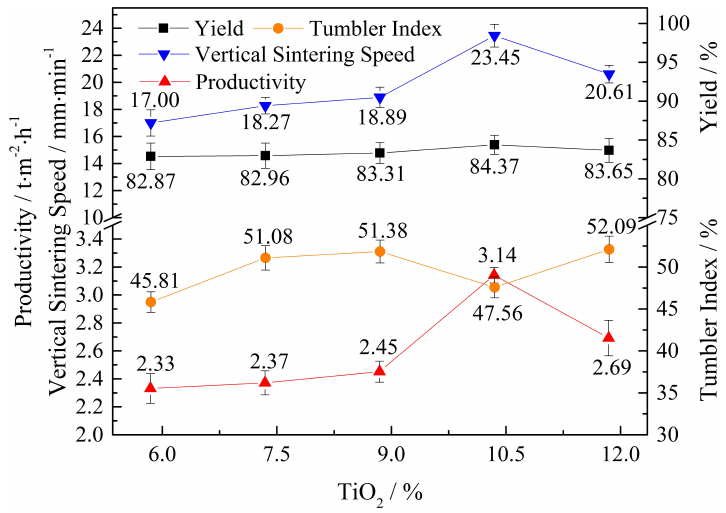
Figure 5. Properties and strength of CVTM sinter with different TiO 2 content.